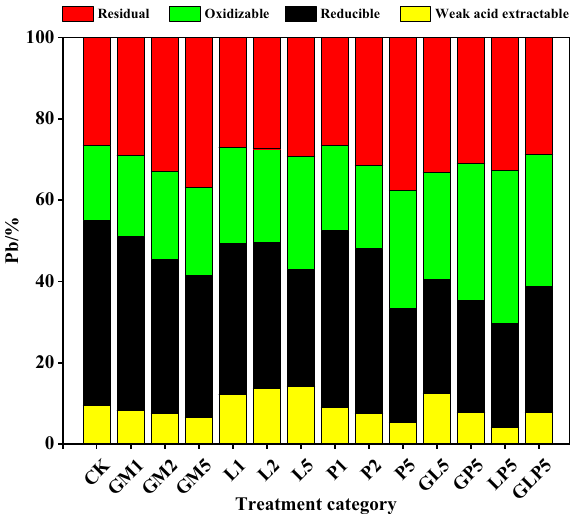
Figure 4. Effects of different passivators treatment on the form of Pb (Origin 2019b). (CK: control check, GM: goat manure, L: Ca(OH) 2 , P: Ca(H 2 PO 4 )·2H 2 O, GL: goat manure + Ca(OH) 2 , GP: goat manure + Ca(H 2 PO 4 )·2H 2 O, LP: Ca(OH) 2 + Ca(H 2 PO 4 )·2H 2 O, GLP: goat manure + Ca(OH) 2 + Ca(H 2 PO 4 )·2H 2 O; 1, 2, 5 represents the proportion of